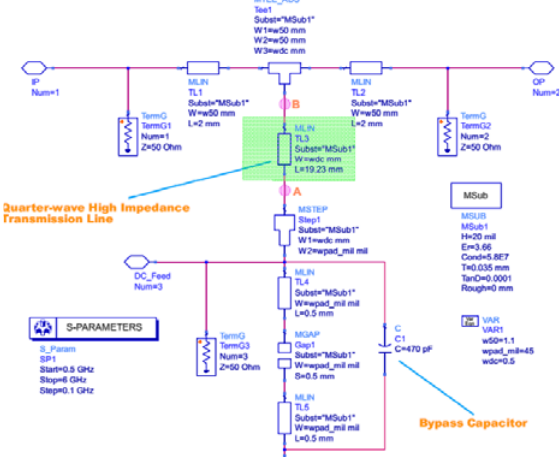
Fig. 4. The proposed biasing network The length of the 90° quarter-wave high impedance center of our frequency band (19.23 mm @ 2.4 GHz).